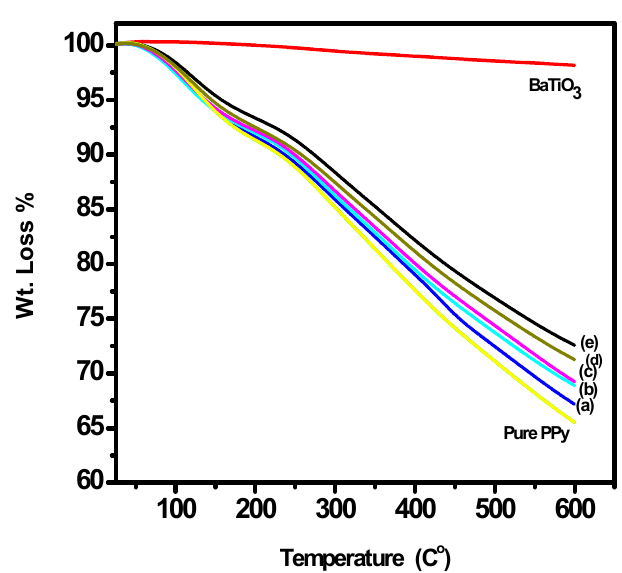
Figure 6. TGA curves of neat PPy, BaTiO 3 and ( a ) PPy/1% BaTiO 3 , ( b ) PPy/2% BaTiO 3 , ( c ) PPy/3% BaTiO 3 , ( d ) PPy/4% BaTiO 3 and ( e ) PPy/5% BaTiO 3 .